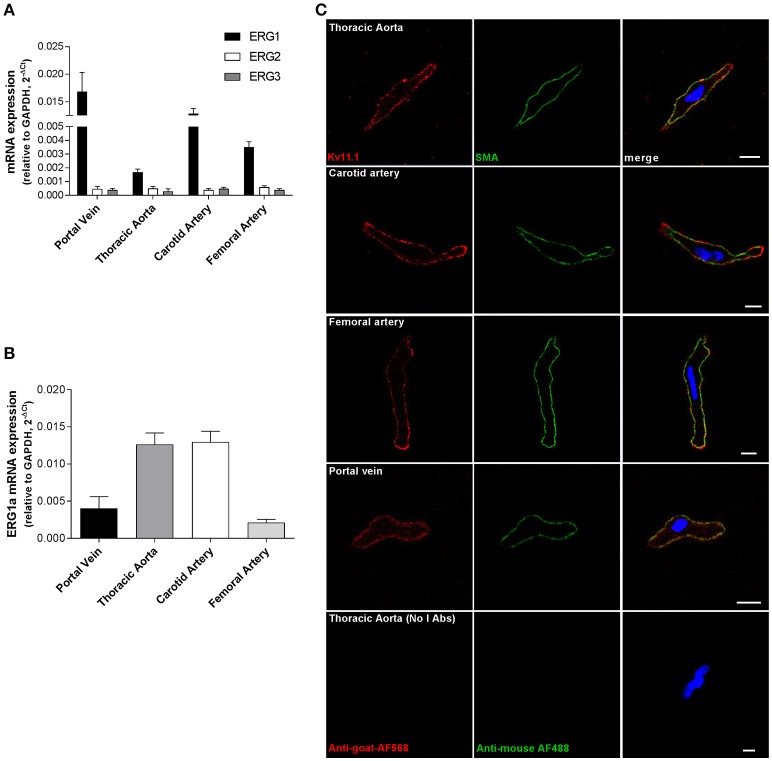
Expression of ERG in mouse vascular smooth muscle. (A,B) Results of quantitative PCR experiments showing expression of ERG1, 2 and 3 (A) and full length ERG1a isoform (B) normalized to GAPDH expression in a range of vascular beds. Each column is the mean of 4 tissues ± s.e.m. Data are expressed using the 2−ΔCt formula (C) Fluorescent images of smooth muscle cells from different vessels labeled with Kv11.1 antibody (left column) and smooth muscle actin (SMA, middle column). Secondary antibodies only (no primary Abs) are shown at the bottom. Each image is representative of 3 separate dispersals. Scale bar = 5 μM.